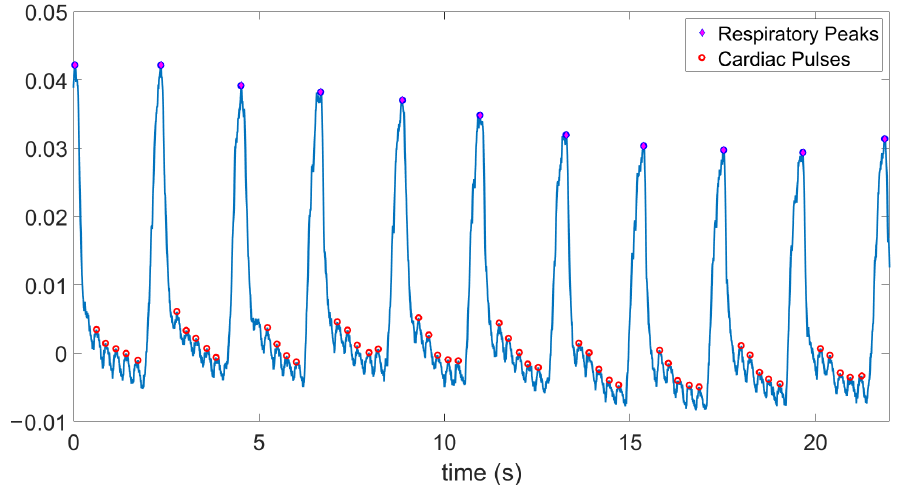
Figure 16. Signal from the AFE4490 evaluation board connected to the probe injected in the anesthetized rat. The respiratory pattern and heart contraction related modulations can be clearly seen. The mean SD of the averaged heart rate values in between each pair of respiratory events is ± 225 6 bpm and that of respiration rate is 27 1.20 breaths per ± ±